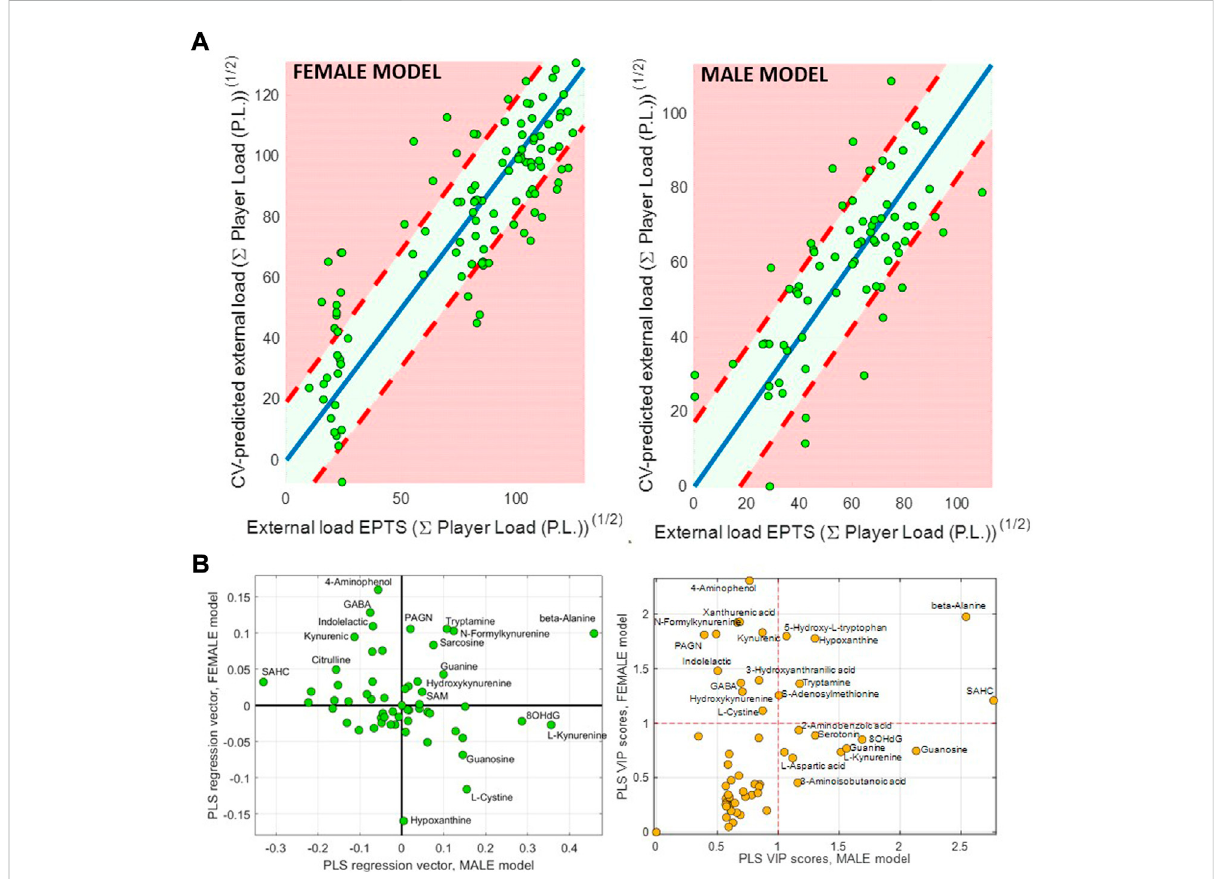
FIGURE 3 Partial Least Squares (PLS) analysis. (A) cross-validation (CV) predicted values in the female and male teams. (B) Plot of the PLS regression (left) and VIP score (right) vectors in the PLS models built for the female and male